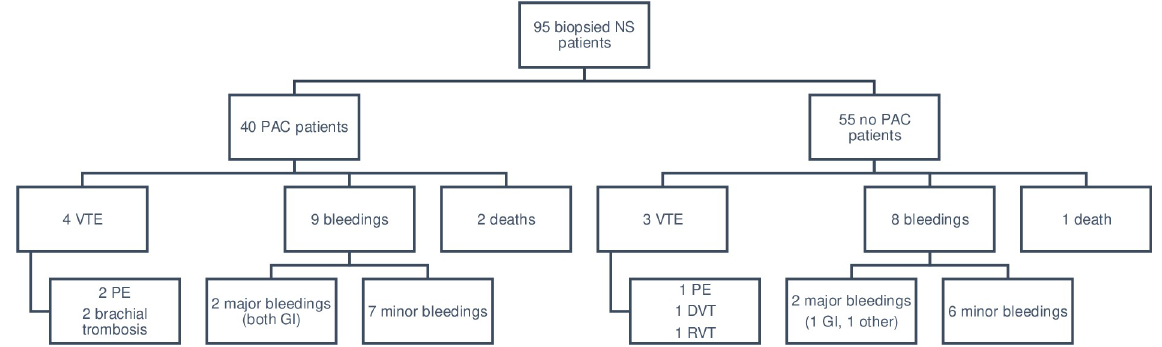
Fig 2. Distribution and specification of outcomes. Outcomes in 95 patients with biopsy-verified glomerular disease and nephrotic syndrome not on anticoagulants prior to NS debut, divided into patients treated with prophylactic anticoagulation treatment (PAC) or not (no PAC). One patient had both a major bleeding and (not bleeding related) death, one patient had a major bleeding and a subsequent VTE. No statistical differences in outcome frequency between the PAC and no PAC groups was found using Fisher’s exact